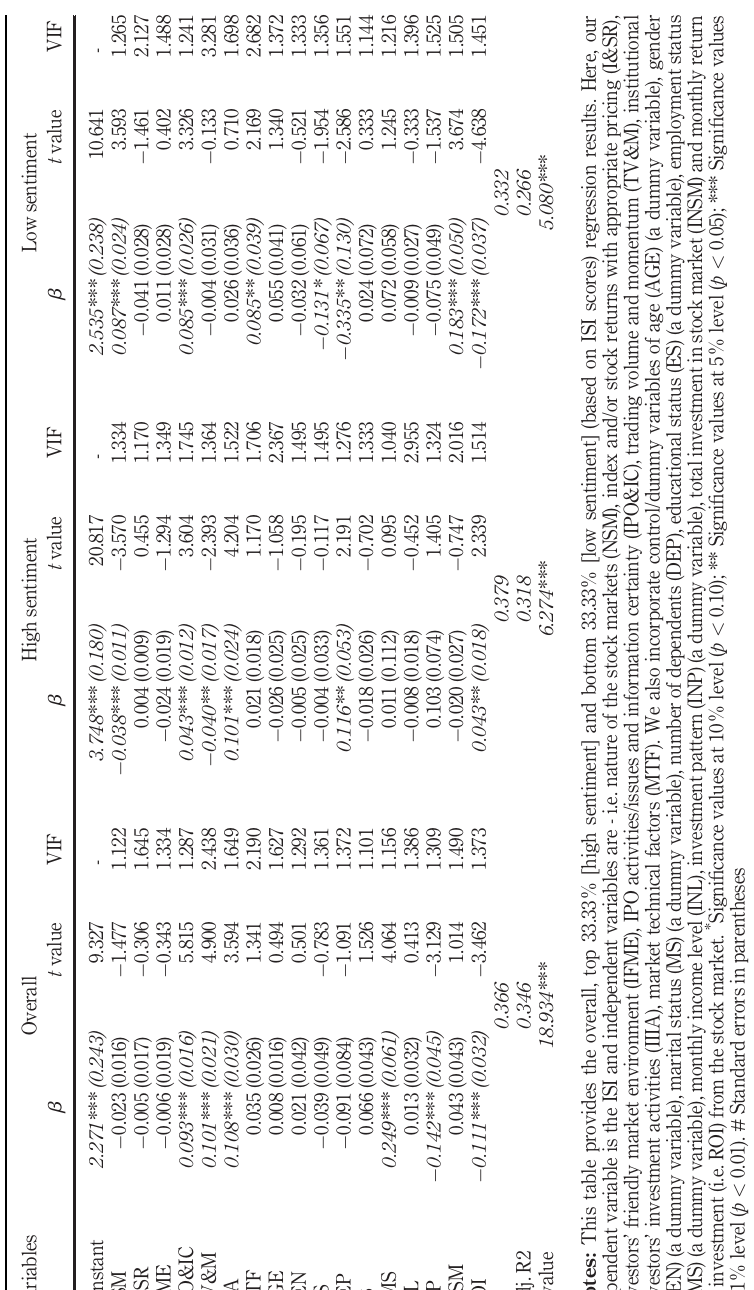
Table 3. Regression